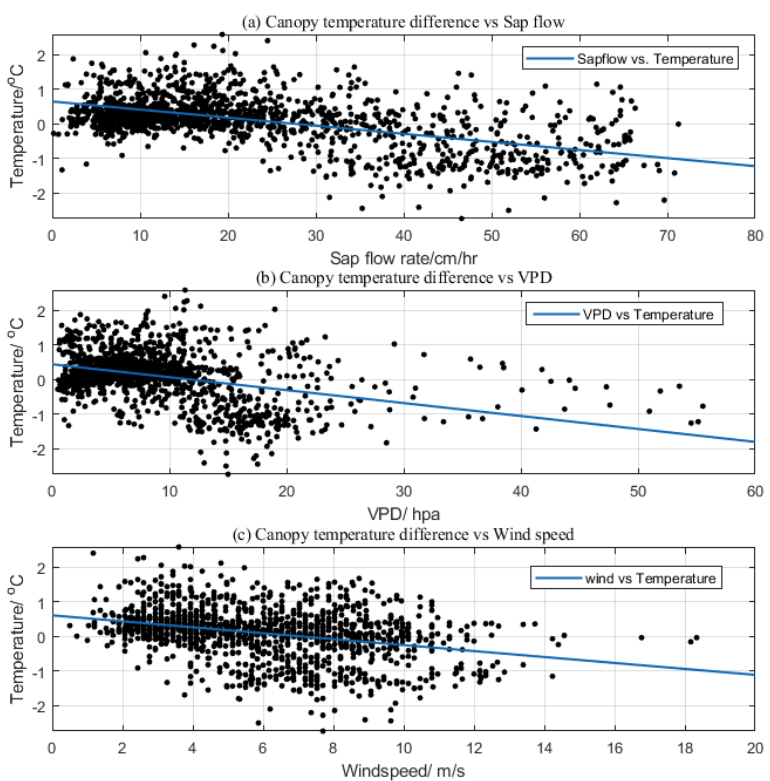
Figure 8. Canopy temperature difference between ( a ) sap; ( b ) VPD; ( c ) wind speed. The R squares are 0.30, 0.15, and 0.14, respectively.